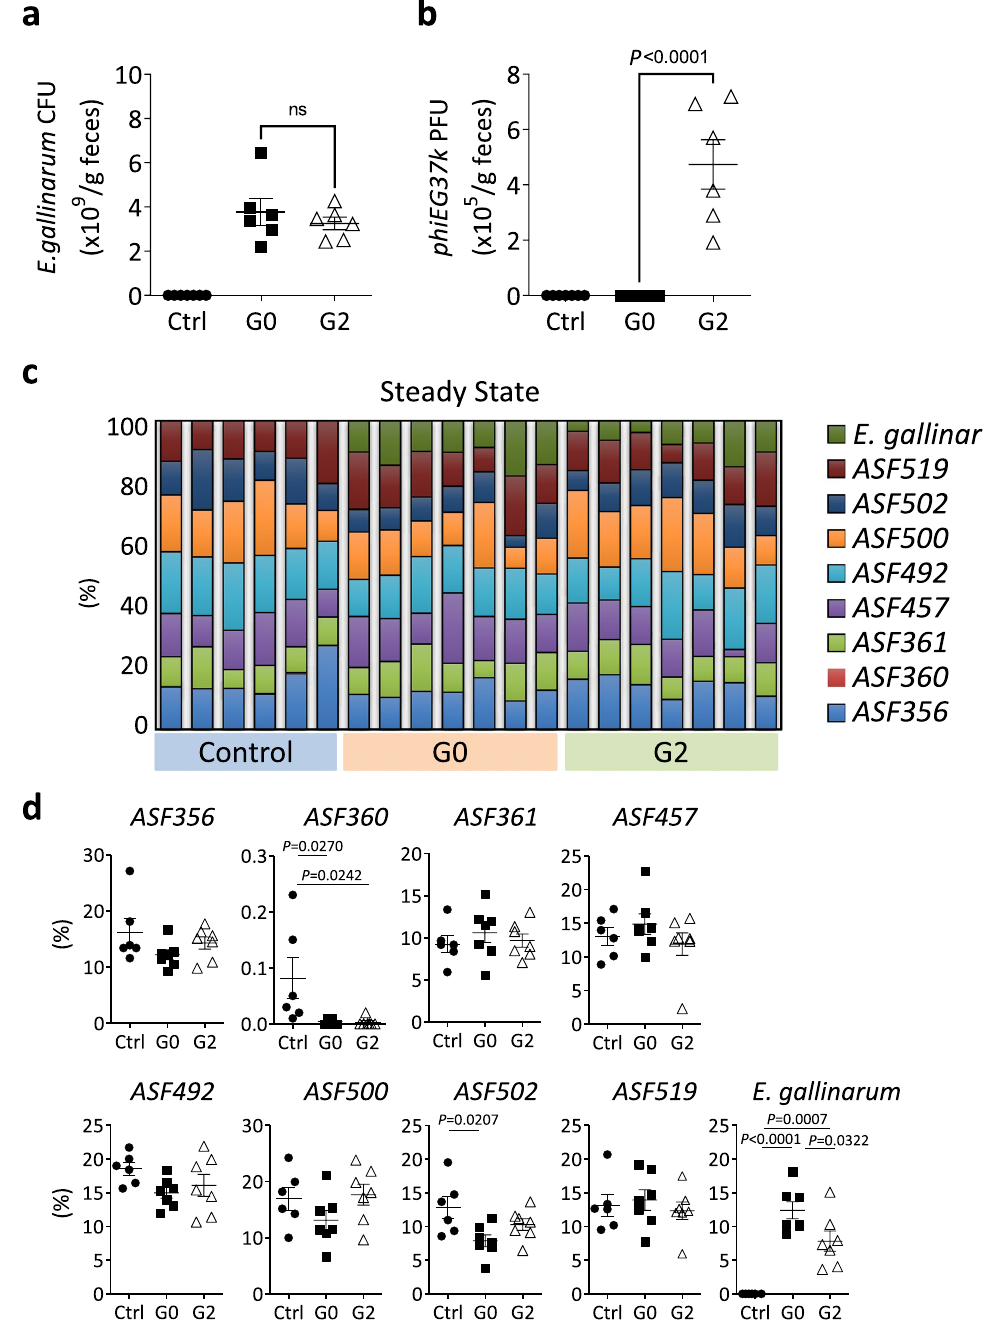
Figure 3. Stable colonization of E. gallinarum bearing lysogenic phiEG37k phage produces residual phage particles in the colon. C57BL/6 mice that have Altered Shaedler Flora (ASF-mice) were gavaged E. gallinarum either free from ( G0 strain) or bearing lysogenic phiEG37k ( G2 strain). ( a and b ) Titers of E. gallinarum ( a ) and phiEG37k ( b ) in feces from the ASF mice with no Enterococcus colonization (Ctrl), G0 -colonization or G2 -colonization at 4 weeks post-gavage. ( c ) Components of colonic microbiota in mice of the three groups described in ( a ). ( d ) Abundancy of individual bacteria consisting of ASF or E. gallinarum in the colon from mice described in ( a ) was displayed. One way analysis of variance with Tukey’s multiple comparison was performed for ad-hoc analysis. ns ; not significant. n =